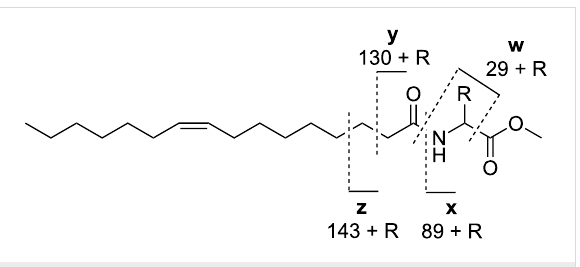
Figure 7: EI mass spectrometric fragmentation of N -acylated amino acid derivatives. The ions w – z allow identification of the respective amino acid